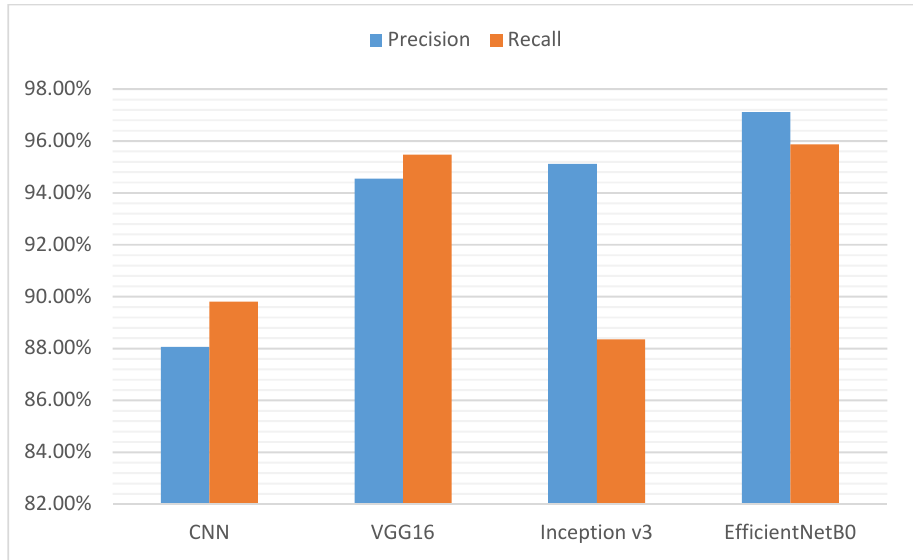
Figure 5. Data analysis results of trained models.